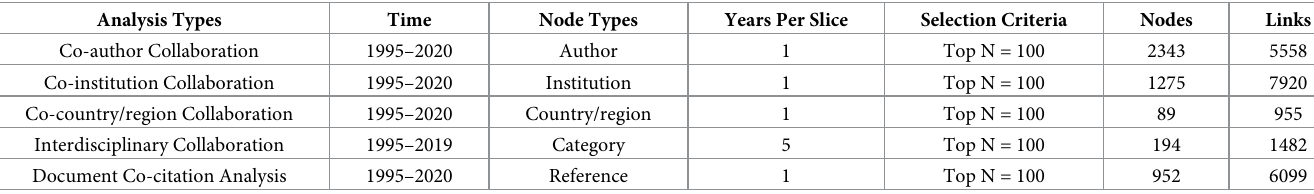
Table 1. Parameters of collaboration network